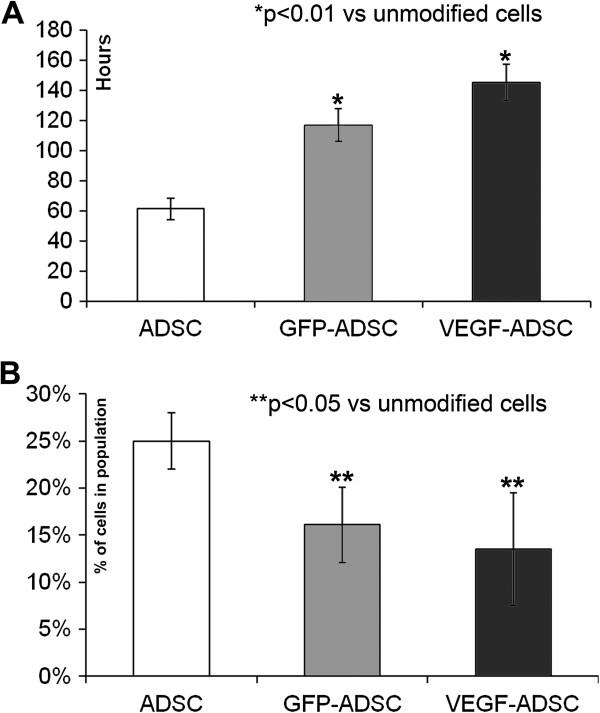
Proliferation of gene modified ADSC. A. Population doubling time in GFP-ADSC, VEGF-ADSC and ADSC cultures. Data of five serial runs. B. Cells distribution in S-G2 cell cycle stages according to cytometry analysis of GFP-ADSC, VEGF-ADSC and ADSC. Data of three serial runs.